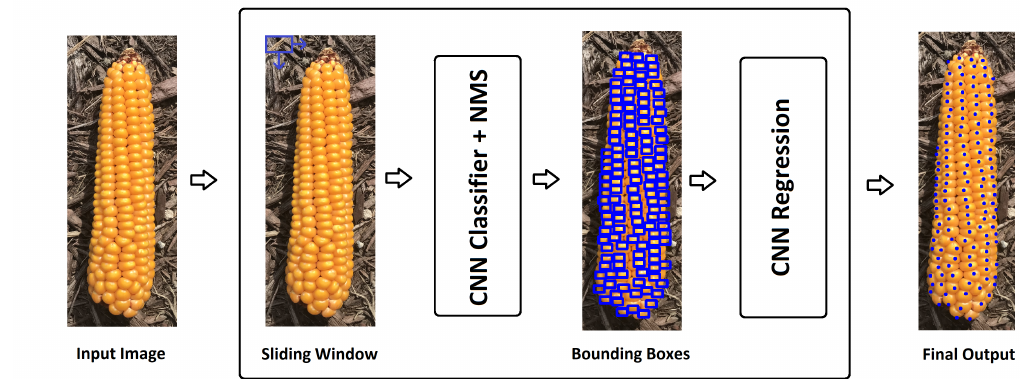
Figure 2. Modeling structure of our proposed corn kernel detection method. A detailed description is given in Section 2.